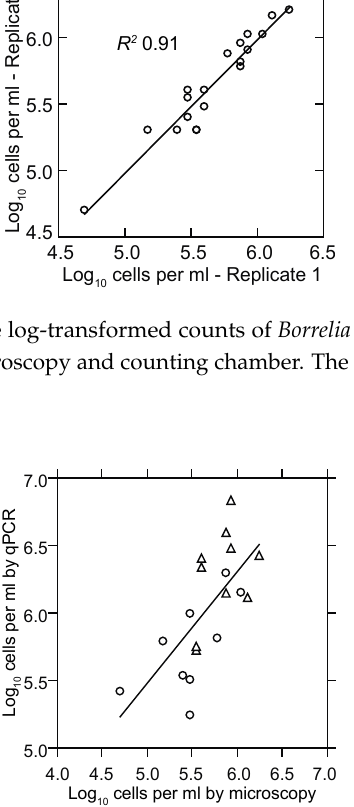
Figure 2. Scatter plot with linear regression of log-transformed counts of B. hermsii cells in plasma by phase microscopy and counting chamber ( x -axis) and quantitative PCR (qPCR; y -axis). Circles and triangles denote samples of blood taken at hours 94.5 or 102 from immunocompetent BALB/c mice infected at hour 0, as described in the text. The slope (95% confidence interval) for the least-squares regression was 0.85 (0.4–1.3), and the combined R 2 was 0.46 ( p < 0.001).